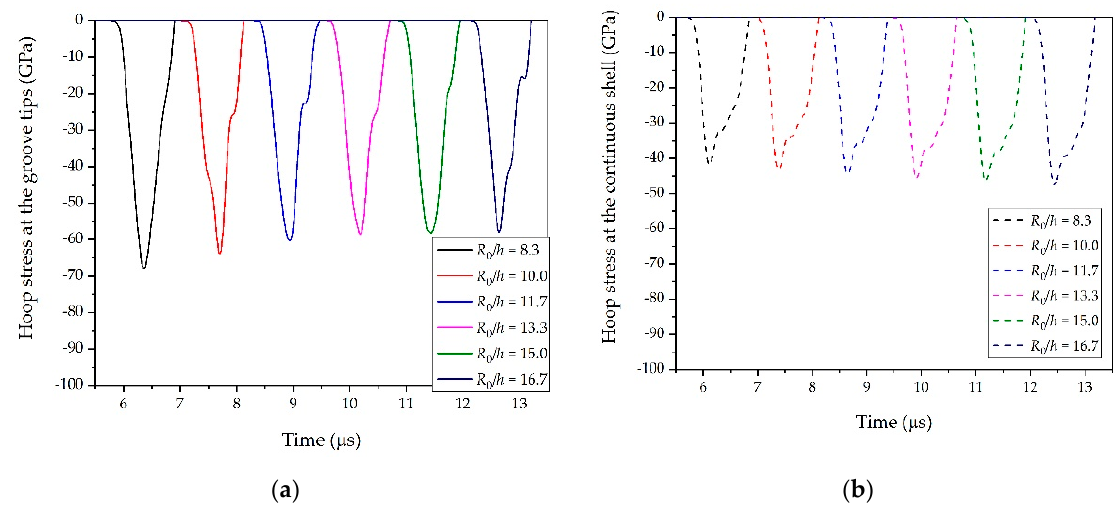
Figure 14. Hoop stress at groove tips and the stress at the same position inside the continuous shell (NO. 7): ( a ) relationship between R 0 / h and hoop stress at groove tips and ( b ) relationship between R 0 / h and the stress at the same position inside the continuous shell.